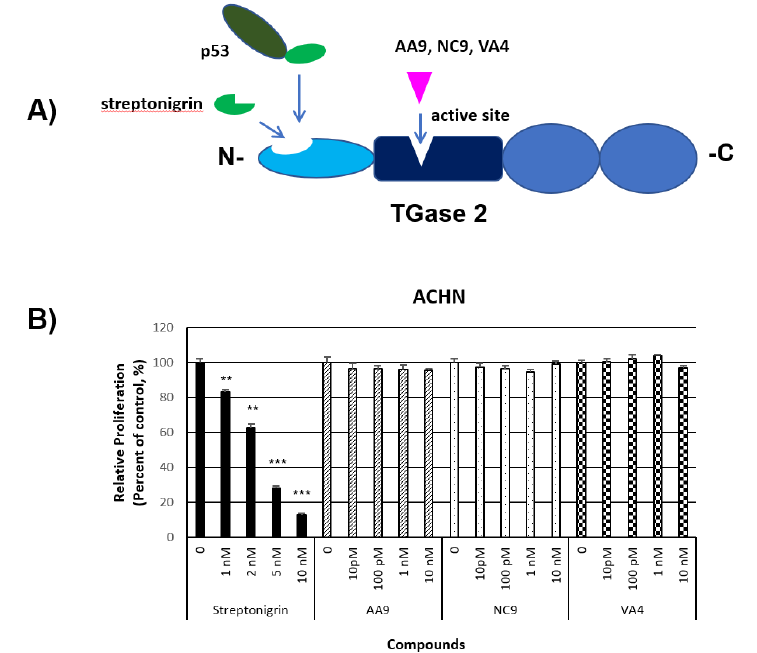
Figure 2. Inhibitor targeting the N-terminus p53 binding region of transglutaminase 2 (TGase 2) shows an anti-cancer effect in clear cell renal cell carcinoma (ccRCC), cell line ACHN. ( A ) Streptonigrin binding to N-terminus of TGase 2 stabilized p53, which induced apoptosis in ccRCC. AA9, NC9, and VA4 binding to active site of TGase 2 caused inactivation of TGase 2. ( B ) Cells were tested for proliferation assay using sulforhodamine B assay as reported [23] for 48 h with the indicated concentrations of streptonigrin, AA9, NC9 and VA4 compounds. Streptonigrin showed an anti-cancer effect in a dose-dependent manner, while TGase 2 active site inhibitors such as AA9, NC9, and VA4 [72] did not show an anti-cancer effect in ccRCC. This suggests that TGase 2 mediated p53 depletion is not dependent on enzyme activity but related to an N-terminal binding chaperone effect to the autophagosome. (mean ± SD, n = 3) ** p < 0.01, and *** p < 0.001.